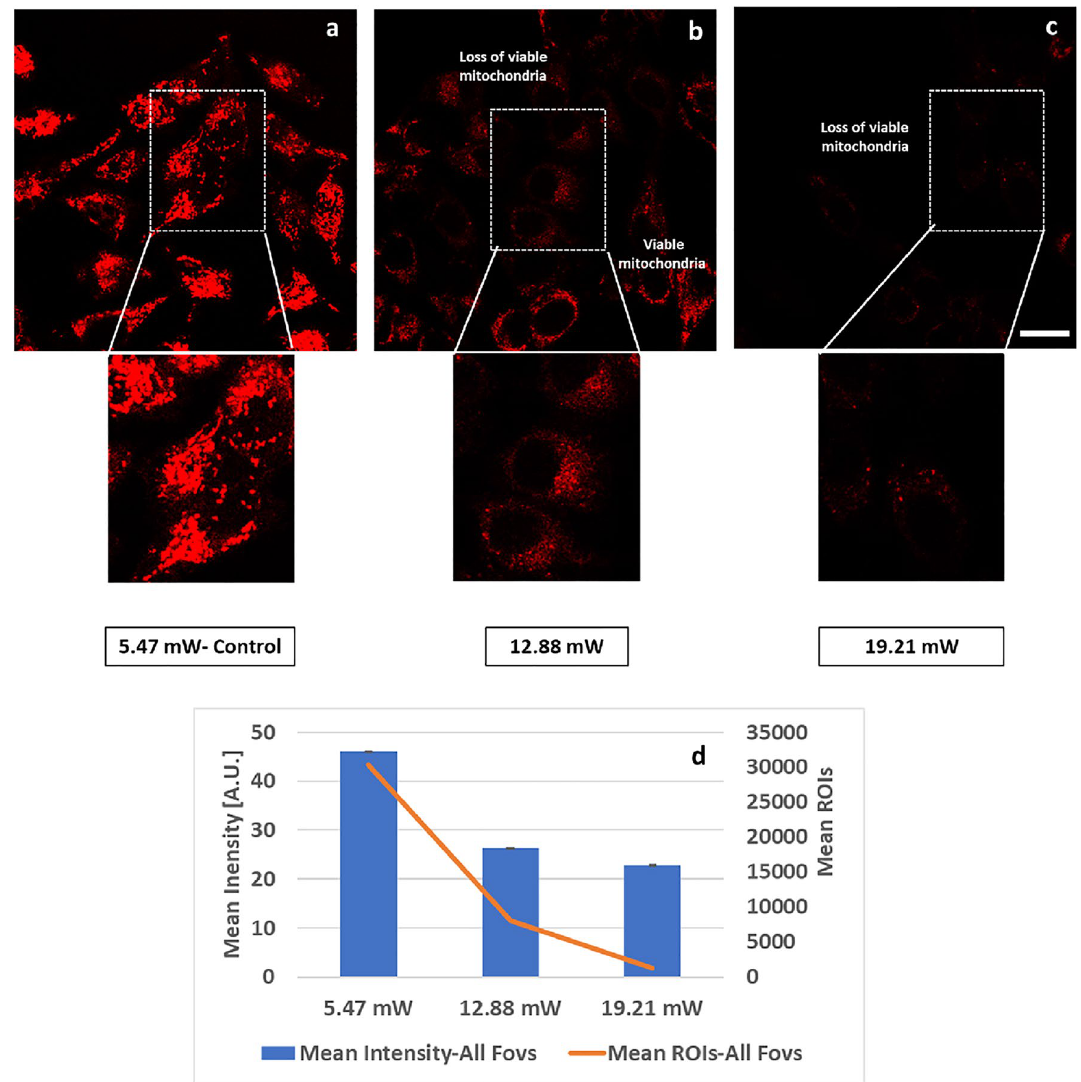
Figure 4. Loss of mitochondrial membrane potential (ΔΨm) at increasing 2p-laser power in HeLa Cells. ( a ) Representative confocal image of MitoTracker CMXRos signals (after FLIM acquisition at 5.47 mW, control laser power) showing viable mitochondria. ( b ) Loss of MitoTracker CMXRos confocal signal (after FLIM acquisition at 12.88 mW laser power) due to loss in mitochondrial ΔΨm. ( c ) After FLIM acquisition at 19.21 mW, MitoTracker CMXRos signals disappeared; it was pointless to track FOVs at 25.45 mW power. All confocal images were taken at identical conditions with 561 nm excitation at 0.3% power (Em 579–712 nm, PMT 630v). ( d ) Mean intensity (± SEM) bar plots and mean ROIs counts (2 × 2 pixel, orange line) from 4 FOVs show decrease in MitoTracker CMXRos mean intensity from 46 to 26.3 Gy-levels (8-bit image depth), a 42.84% decrease, and to 22.7—a 50.65% decrease. Mean ROI counts declined from 30,335 to 8,011.25 (73.63% decrease) and to 1,284.75 (95.77% decrease) after FLIM at 5.47 mW-Control, 12.88 mW and 19.21 mW respectively, demonstrating drop in signal with higher laser average power. Single factor Anova analysis was done for statistical significance between groups for mean intensity at alpha value of 0.05. The results were statistically significant with p value of < 0.0001 . Scale bar 20 probe. Intensity changes of MitoTracker CMXRos are dependent on the physiological mitochondrial membrane potential (Fig. S1). Representative images and insets of MitoTracker CMXRos signals from viable mitochondria were seen with laser average power of 5.47 mW-Control (Fig. 4a), whereas loss of signals was observed after higher average power excitation at 12.88 mW (Fig. 4b) and 19.21 mW (Fig. 4c). Continuing to a higher power at 25.45 mW was pointless, considering the results at 19.21 mW. Some viable mitochondria outside of the FOV were still seen with 12.88 mW (Fig. 4b), which were completely lost with 19.21 mW irradiation (Fig. 4c). Our compiled results from all FOVs clearly demonstrate that excitation with higher average power resulted in the loss of physiological mitochondrial membrane potential leading to the loss of MitoTracker CMXRos labeling of the mitochondria (Fig. 4d). With respect to 5.47 mW-Control, a decrease of 42.84% with 12.88 mW and 50.65% with 19.21 mW